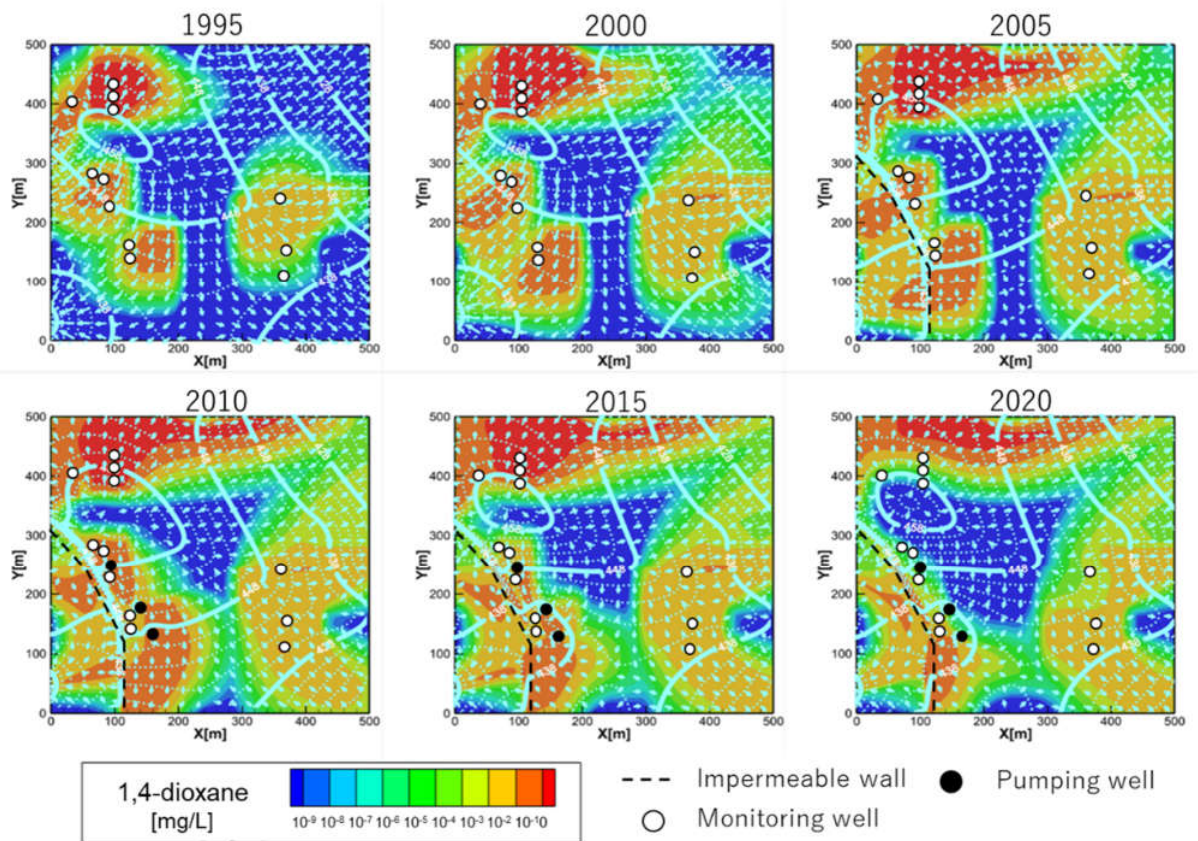
Figure 3. Distribution of groundwater pollution of 1,4-dioxane in the site over time (1995–2020). Contour lines indicate groundwater levels and vectors indicate flow directions. The color of the legend indicates the concentration of 1,4-dioxane .